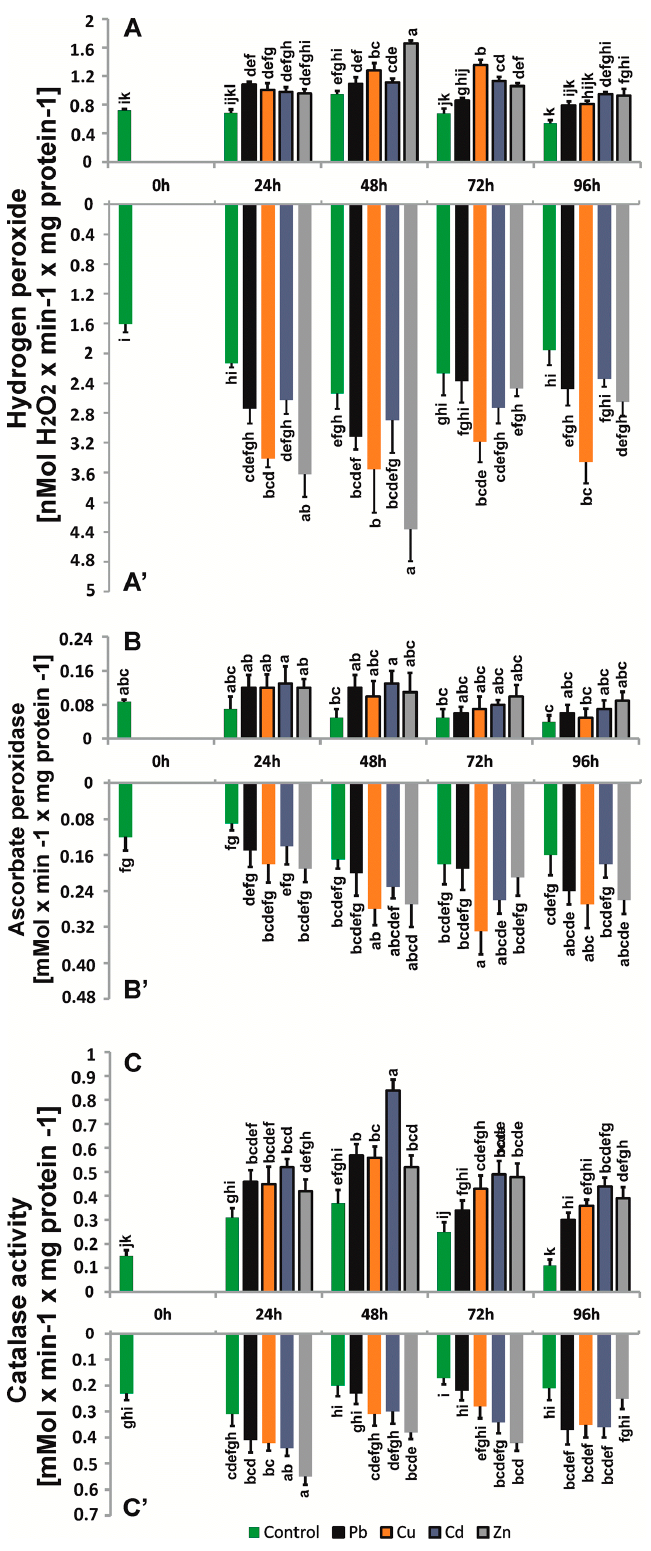
Figure 4. Hydrogen peroxide level (nMol H 2 O 2 × min − 1 × mg protein − 1 ), CAT ( µ Mol min − 1 mg − 1 protein), and APX ( µ Mol × min − 1 × mg protein − 1 ) activities in roots and above-ground parts of B. juncea var. Malopolska seedlings grown in Hoagland’s medium and treated with lead, cooper, cadmium, and zinc ions. Metal solutions Pb(NO 3 ) 2 , CuSO 4 , CdCl 2 , and ZnSO 4 were applied at a 50 µ M concentration. Mean values of three replicates ( ±